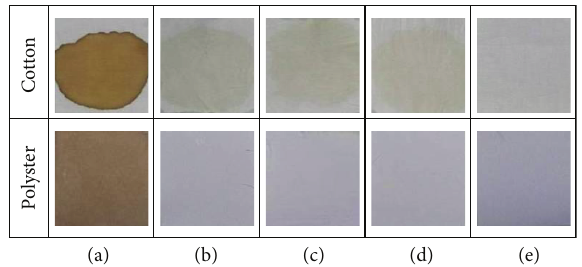
Figure 5: Detergency test results-cleaning performances of SLJO and commercial detergent and their combination against coffee stain. (a) Coffee stained fabrics (b) washed with commercial detergent, (c) washed with SLJO, and (d) washed with SLJO and commercial detergent 1: 1 (e) unstained